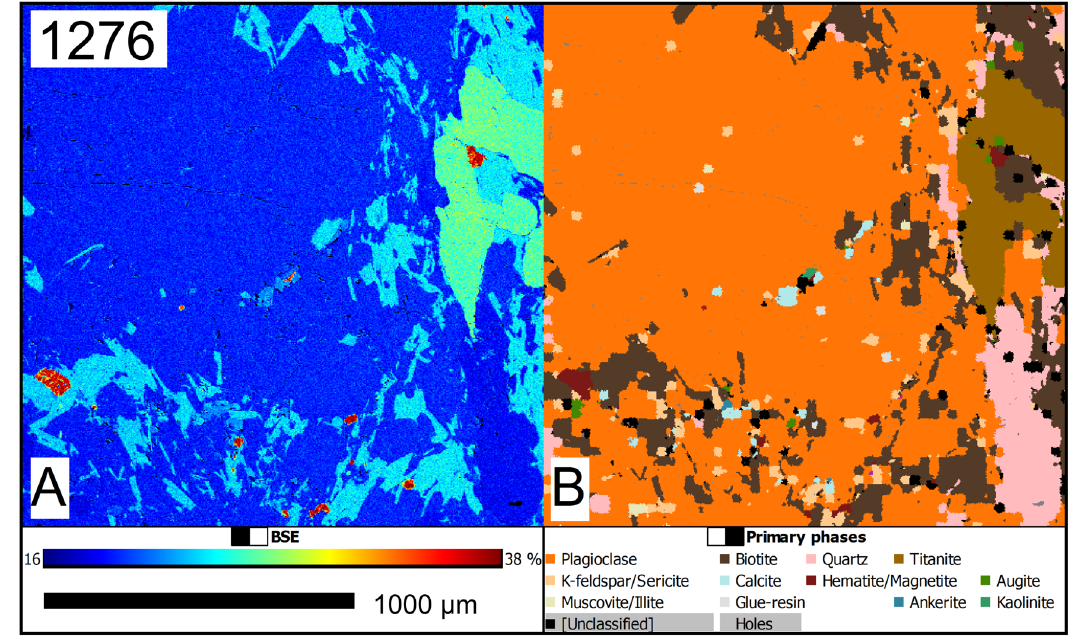
Fig. 6 Representative images of Akia Terrane tonalite containing titanite. A False color backscatter electron (BSE) image of sample 1276, Tonalite, showing titanite (green). False color gradient scale bar denotes BSE intensity. The red minerals denote Fe oxide phases. B phase map of the same region.